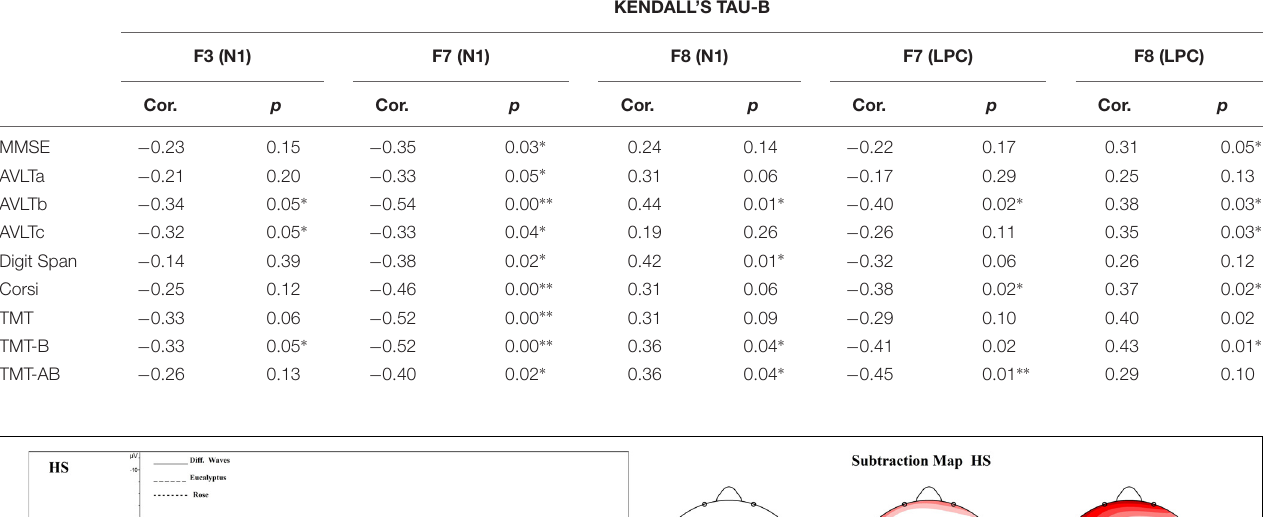
TABLE 4 | Kendall’s tau-b correlation coefficients relating neuropsychological test scores and OERP amplitudes significantly affected in the MCI group (F3, F7, and F8 in N1 component and F7 and F8 in LPC component).